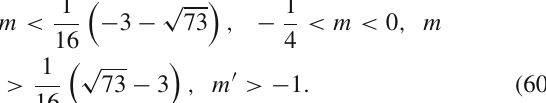
stable. The black line represents the line n = s − 1 and the green points indicate dark energy solutions which correspond to P 6 fixed points for hypothetical roots s u . These roots are the intersection of n ( s ) of the model (the red curve ) with the line n = s − 1. The blue line shows the curve n ( s ) for model with h ( − T ) = c 2 exp [− c 1 ( − T ) − β( − T ) 4 / 12 ] , which is discussed in Sect.